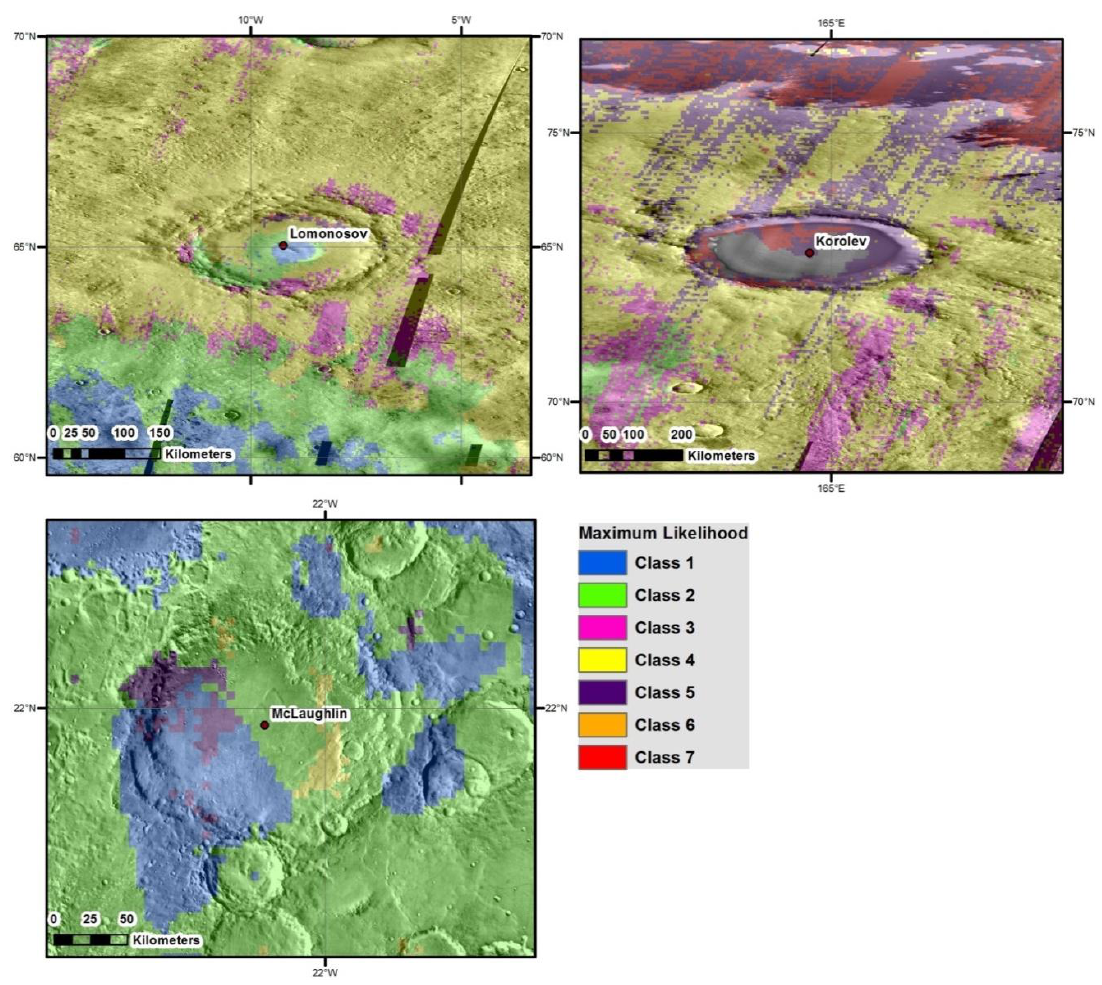
Figure 19. Impact craters delineated in the thermophysical map (Figure 13) overlaid on the THEMIS daytime-IR basemap. Lomonosov crater has diameter ~150 km; Korolev ~84 km, and McLaughlin ~92 km. Image credit: NASA Mars